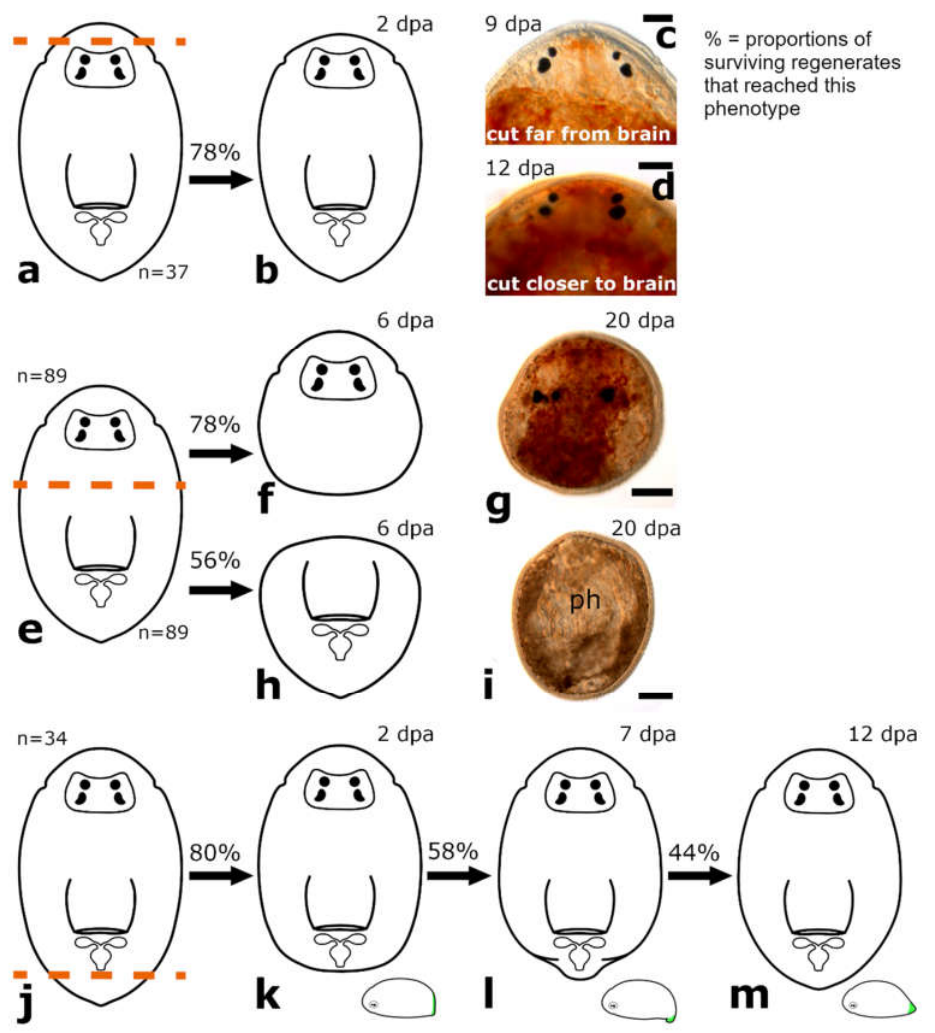
Figure 3. Regeneration in Monoophorum striatum . Amputation anterior to the brain ( a ); anterior regenerates fully healed the wound ( b ). The amputated tissue was not restored at any time ( c , d ). Amputation between brain and pharynx ( e ); complete wound healing in posterior regenerates ( f , g ) and anterior regenerates ( h , i ); no further regeneration was observed. Amputation posterior to the pharynx ( j ); posterior regenerates fully healed the wound ( k ). The regenerated tissue was bent towards the ventral side ( l ). The newly build tail tip was not retracted anymore ( m ). Abbreviations: mg, male genital organ; ph, pharynx. Scale bars: 50 µm in ( c ) and ( d ); 100 µm in ( g ) and ( i ).